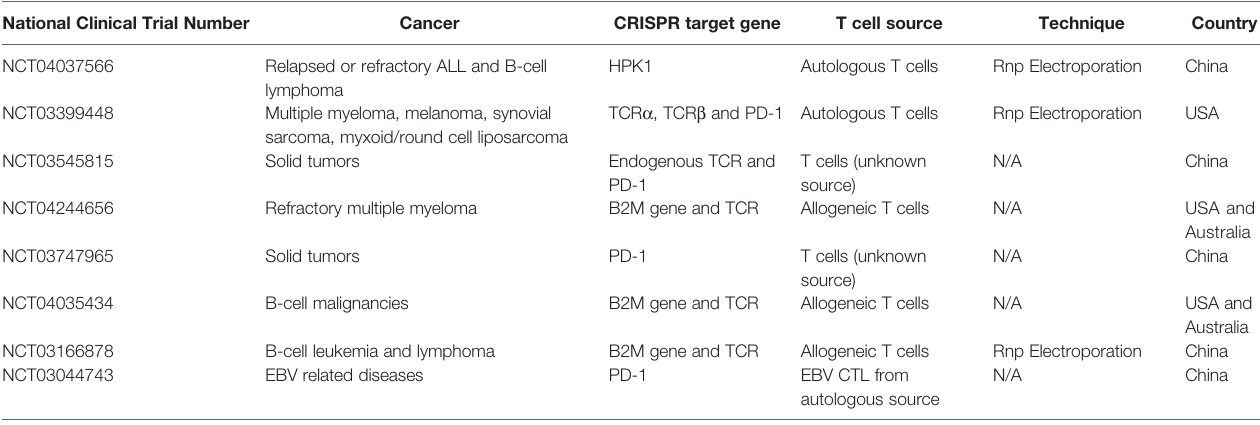
TABLE 1 | Examples of clinical trials with CRISPR/Cas9 gene edited T cells (151). National Clinical Trial